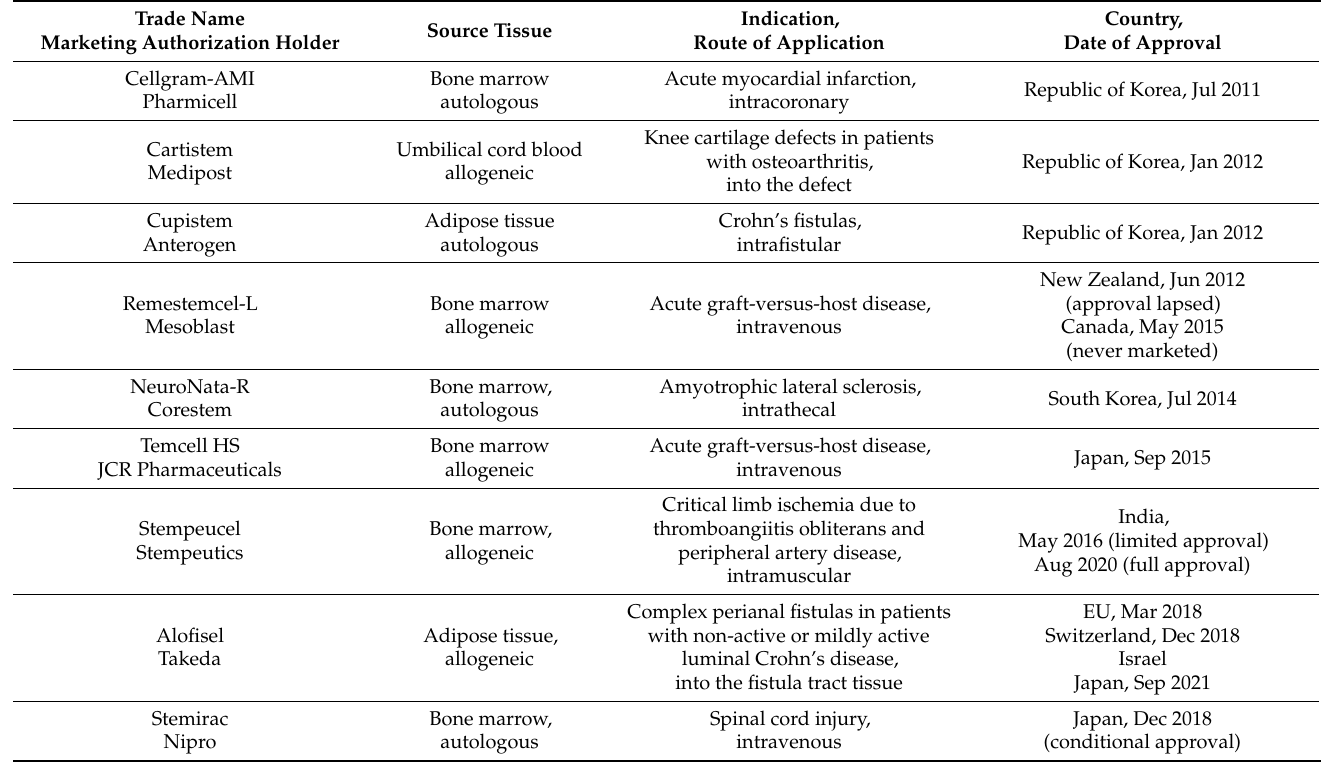
Table 1. MSC-based cell therapy products with marketing authorization in order of the date of (first)